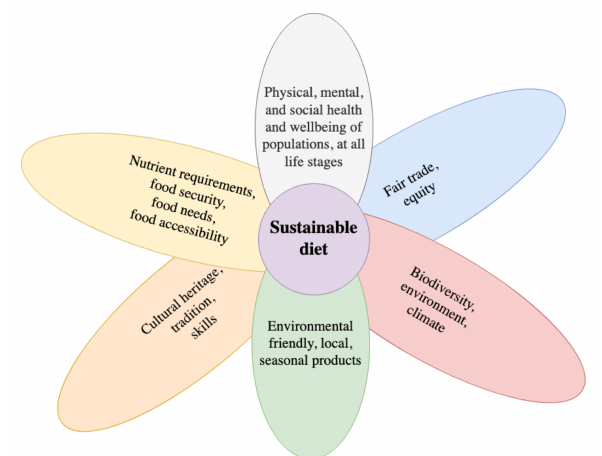
Figure 1. Components of sustainable diets according to the FAO